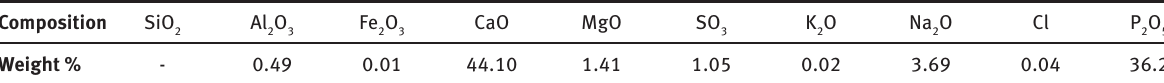
Table 1: Chemical composition of calcined bovine bone powder.